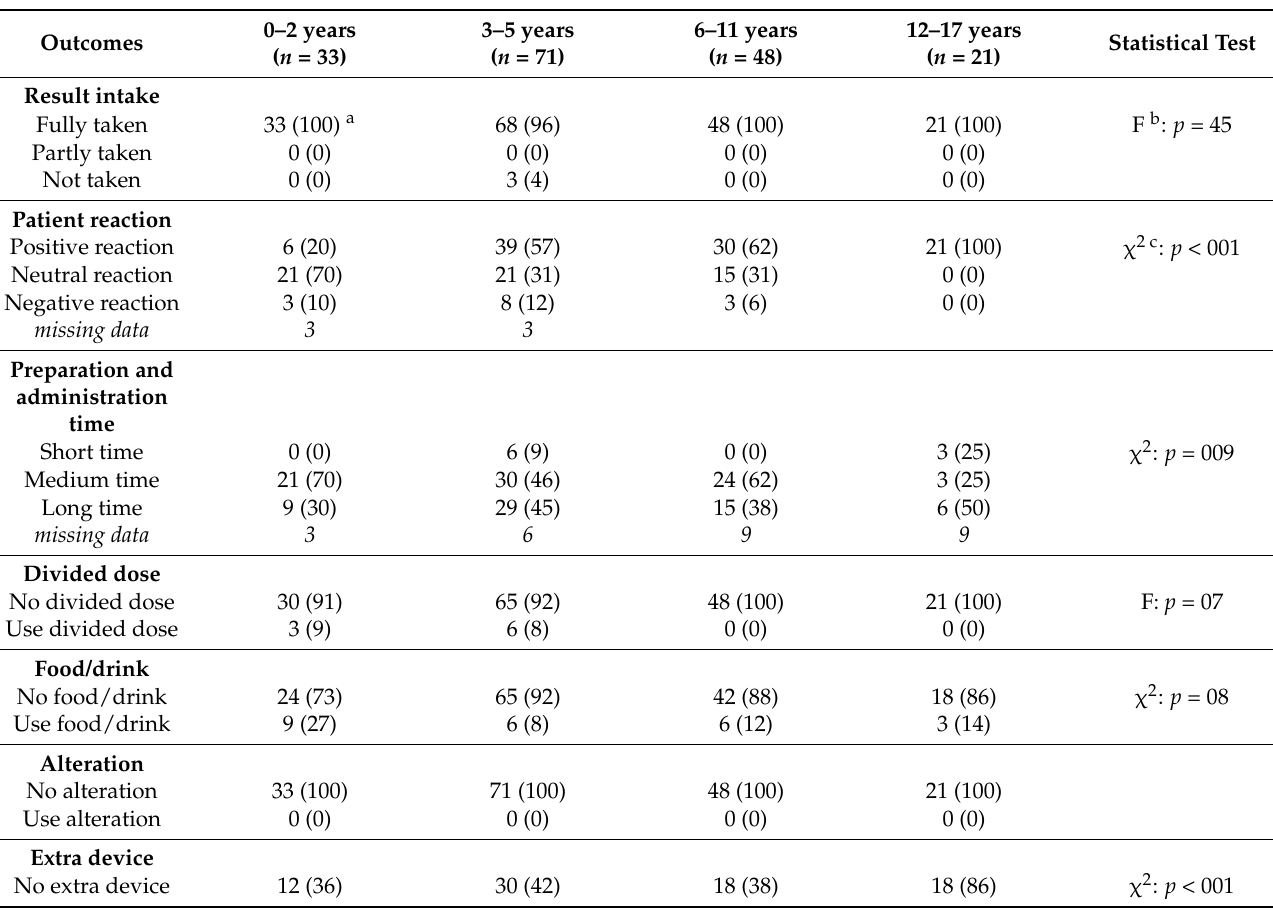
Figure 4. Influence of age on acceptability of cefaclor 10% fine granules. Table 2. Observer-reported outcomes depending of age